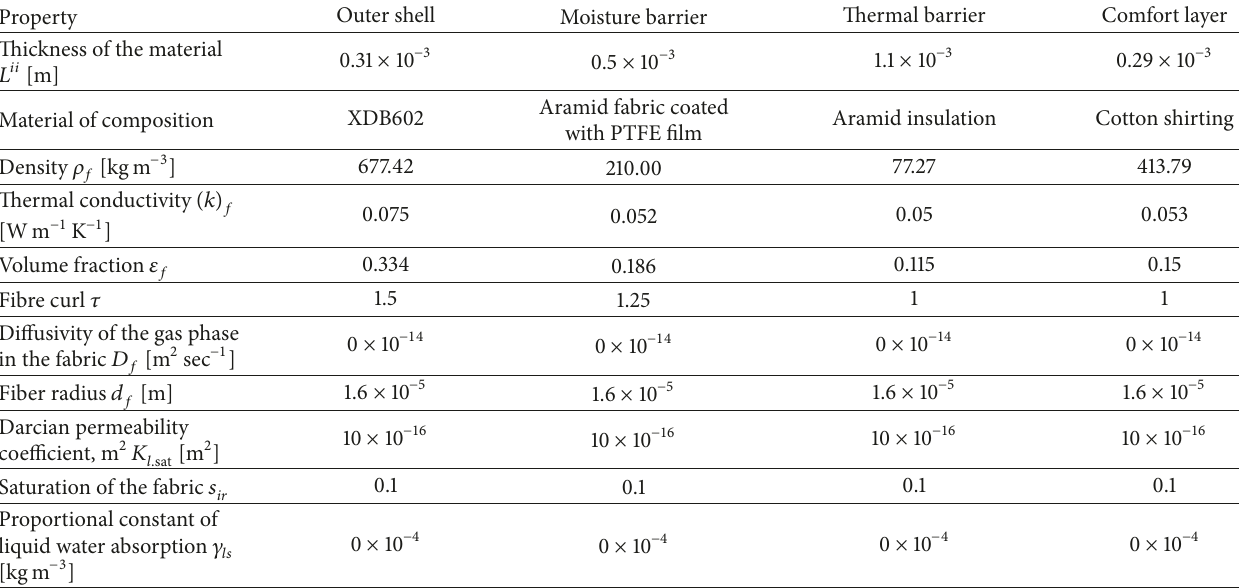
Table 1: Thermophysical and geometrical properties of fabric [17, 21, 22].